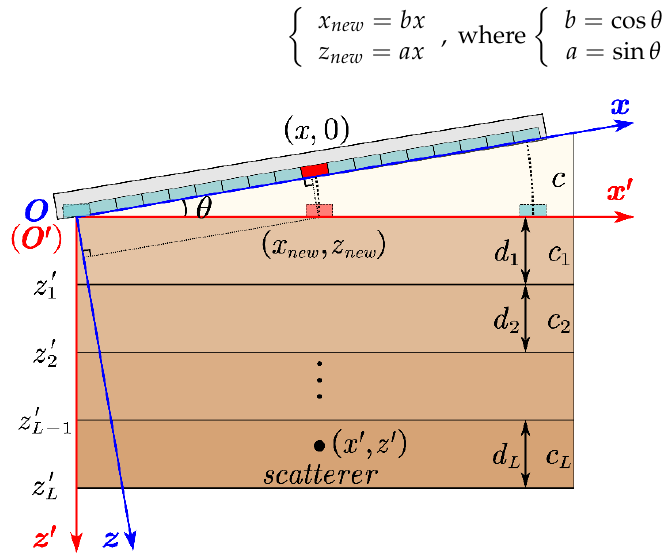
Figure 2. Illustration of oblique incidence for a multi-layered structure. Thus, for the oblique incidence situation, the wave field along the virtual measure- ment line